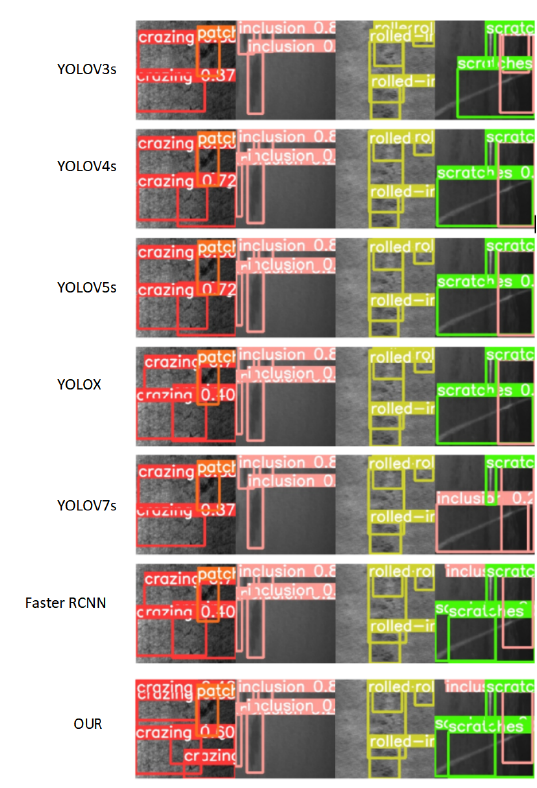
Figure 13. Visualization of different detectors for detecting images on steel